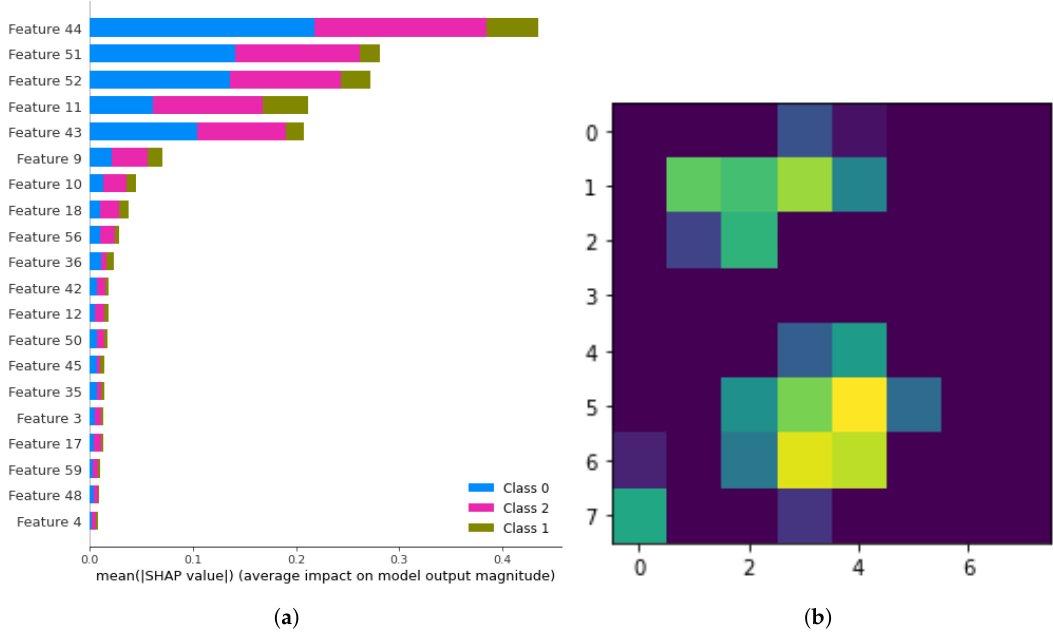
Figure 11. ( a ) Local contributions of pixels for performing good classifications considering heat recordings as time series for input. ( b ) Local contributions of each pixel are highlighted based on the explanations given in ( a ). Brighter pixels contribute more to the classification